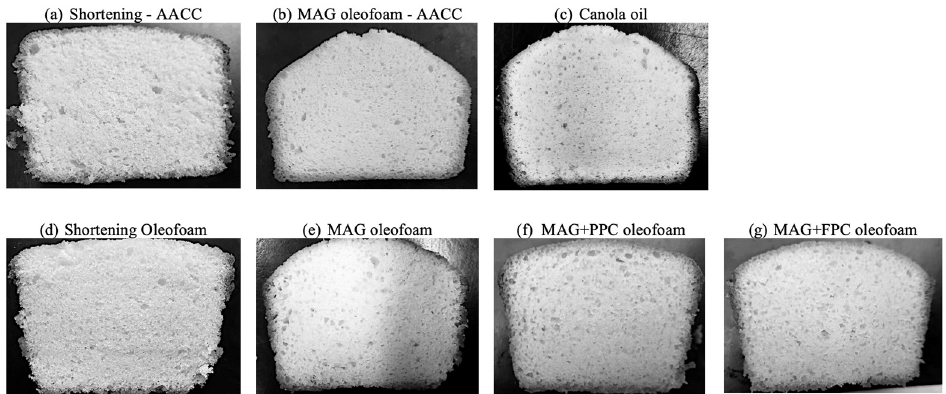
Figure 8. Cross-sectional view of different cakes produced using various fats with either AACC or lab-developed new method. AACC method: ( a ) shortening and ( b ) MAG oleofoam. Lab-developed method: ( c ) canola oil, ( d ) shortening oleofoam, ( e ) 3%MAG oleofoam, ( f ) 3%MAG+PPC oleofoam, and ( g ) 3%MAG+FPC oleofoam. MAG, monoacylglycerols; PPC, pea protein concentrate-stabilized foam; FPC, faba bean protein concentrate-stabilized foam.